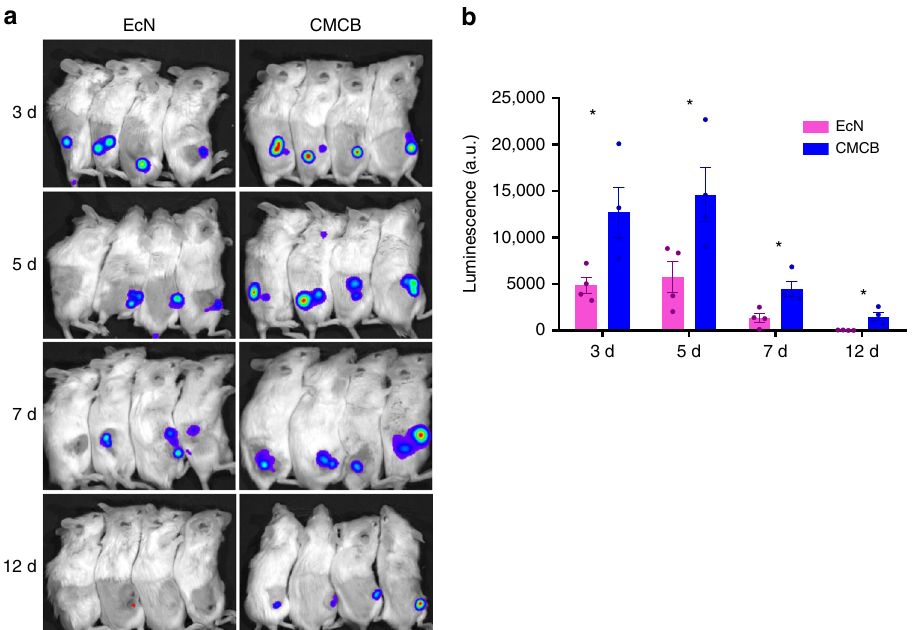
Fig. 5 In vivo tumor imaging. a Tumor imaging of 4T1 tumor-bearing mice at 3, 5, 7, and 12 days post-injection of EcN or CMCB expressing LuxCDABE (1 × 10 7 CFUs). b Intensity of luminescence signals from the tumor sites. Error bars represent the standard deviation ( n = 4). Signi fi cance was assessed using Student ’ s t -test, giving p -values, * p <